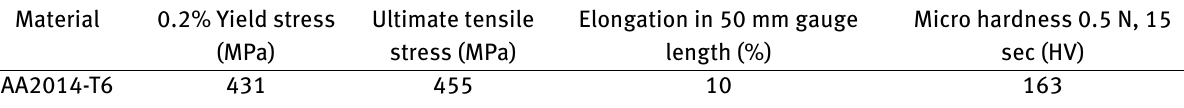
Table 2: Mechanical properties of base material